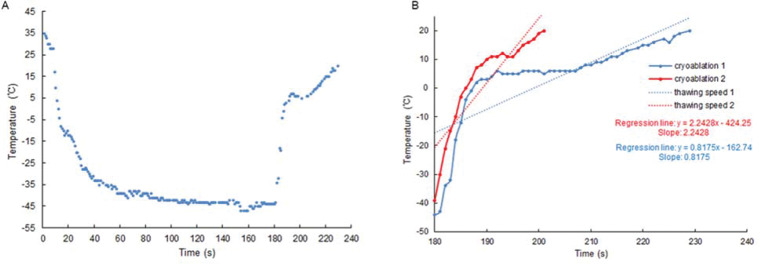
Examples of cryoablation curves and their fitted regression line A, Example of a complete cryoablation curve. B, Examples of a portion of the cryoablation curve (the time frame from the first value >-50°C, with 60s duration) and their fitted regression line.